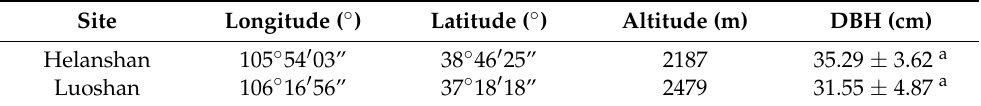
Table 1. Sampling sites and diameter at breast height (DBH) of sampled trees. Site Longitude ( ◦